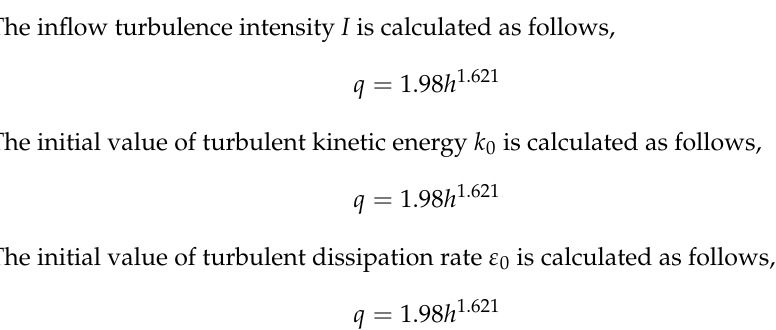
Figure 8. Schematic diagram of boundary conditions.